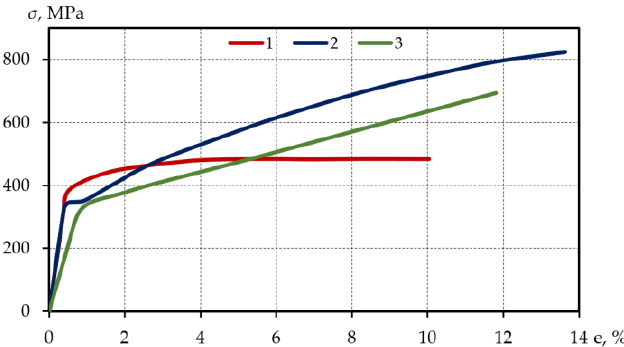
Figure 1. Single uniaxial tensile deformation curves: 1 — aluminium alloy D16T, 2 — structural steel C45, 3 — alloyed steel 15Cr2MoVA.